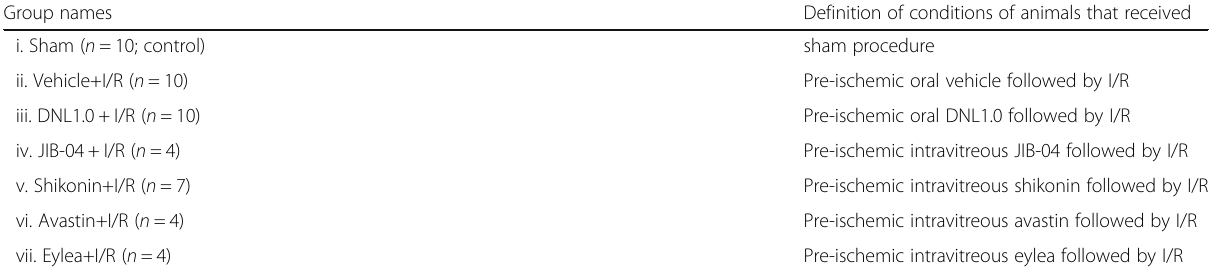
Table 3 Group names and definition of the conditions used to treat the various experimental groups of cells or animals. In vivo Western blotting/ELISA experiment a Group